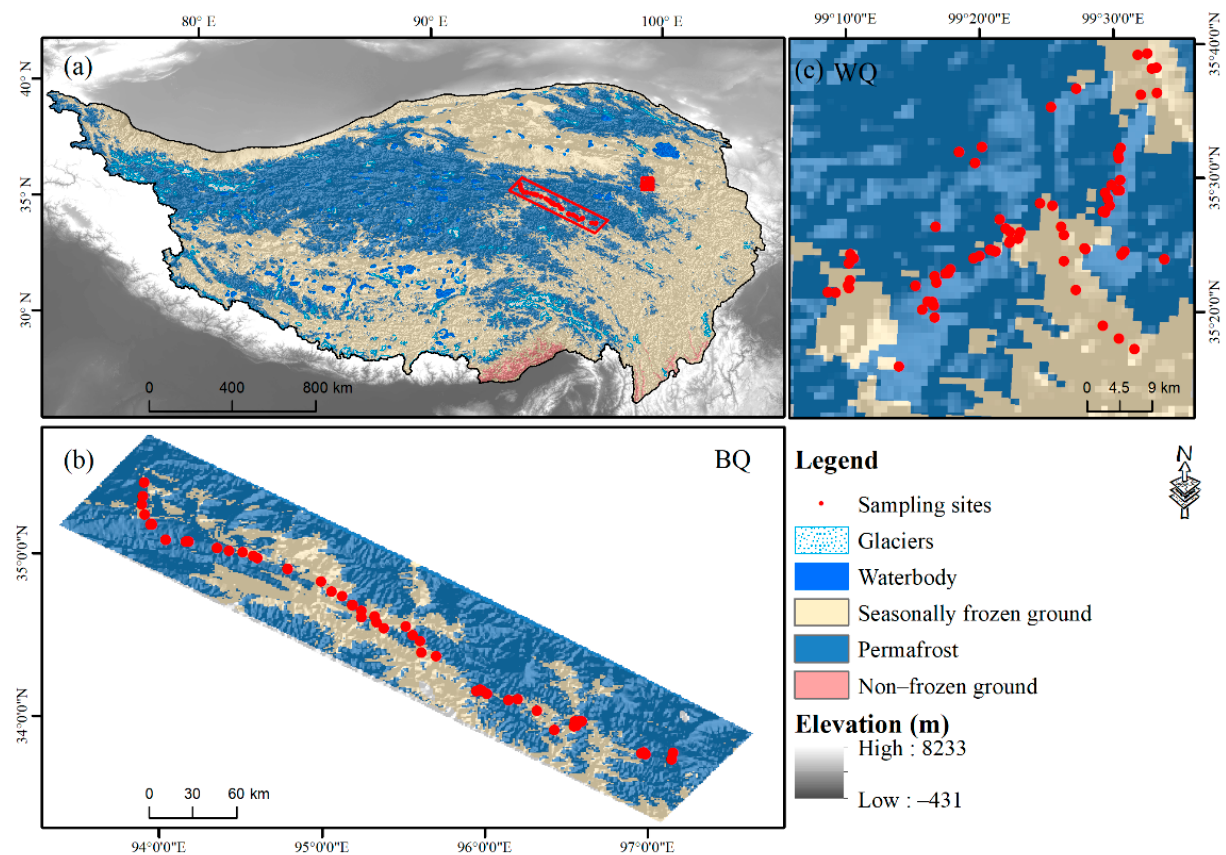
Figure 1. Study areas and sampling locations. ( a ) Identifies the location of two study area on the Qinghai–Tibet Plateau, ( b , c ) present the sampling sites at Budongquan–Qingshuihe and Wenquan, respectively.